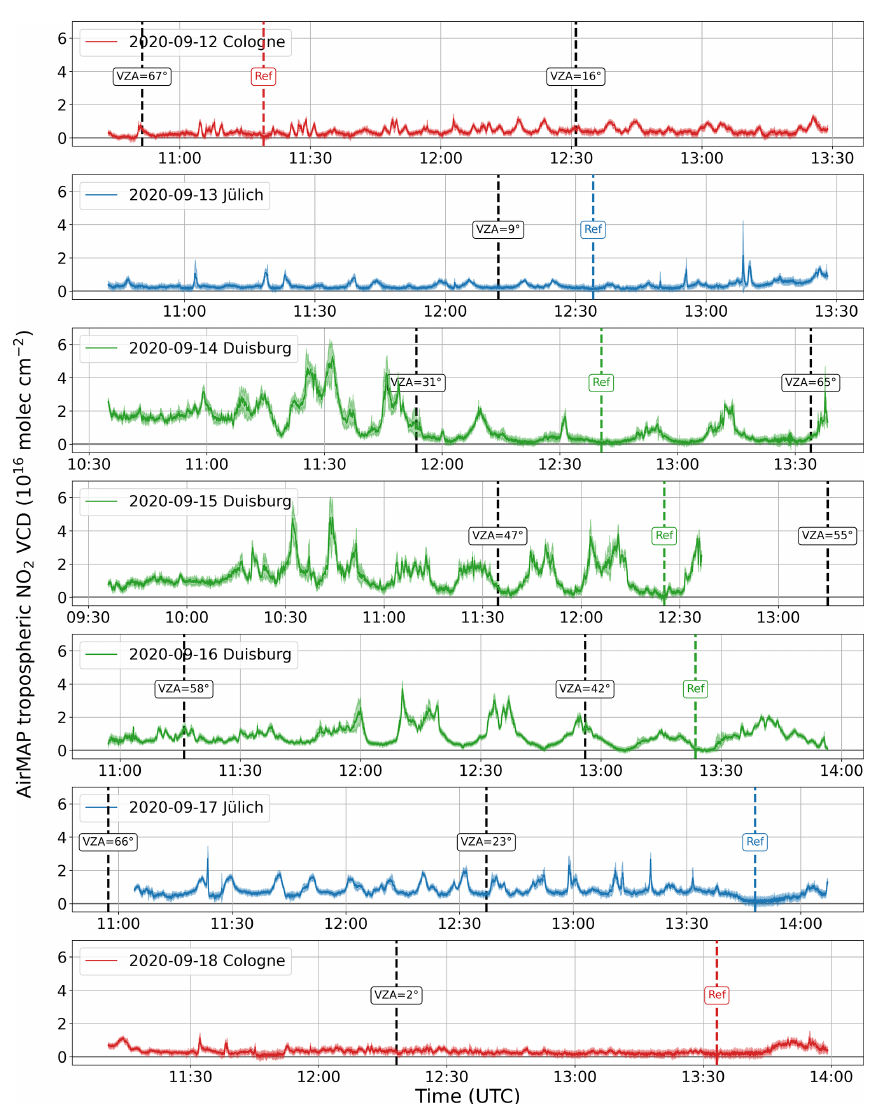
Figure 3. Plots of the AirMAP time series of tropospheric NO 2 VCD (mean over the 35 viewing directions and standard deviation as a dark line and bright area, respectively) for the 7 flight days from Saturday 12 September–Friday 18 September 2020. These show strong variability from day to day (weekday vs. weekend) and between the three target areas (Cologne, Jülich, Duisburg). The dashed black vertical lines indicate S5P overpass times with their viewing zenith angle. The dashed colored vertical lines indicate the times of the AirMAP reference